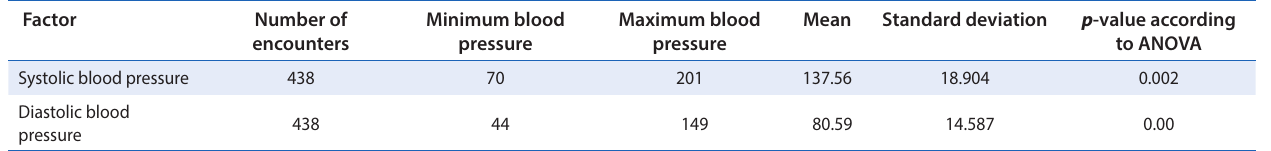
Table 4: Mean blood pressure for all encounters Factor